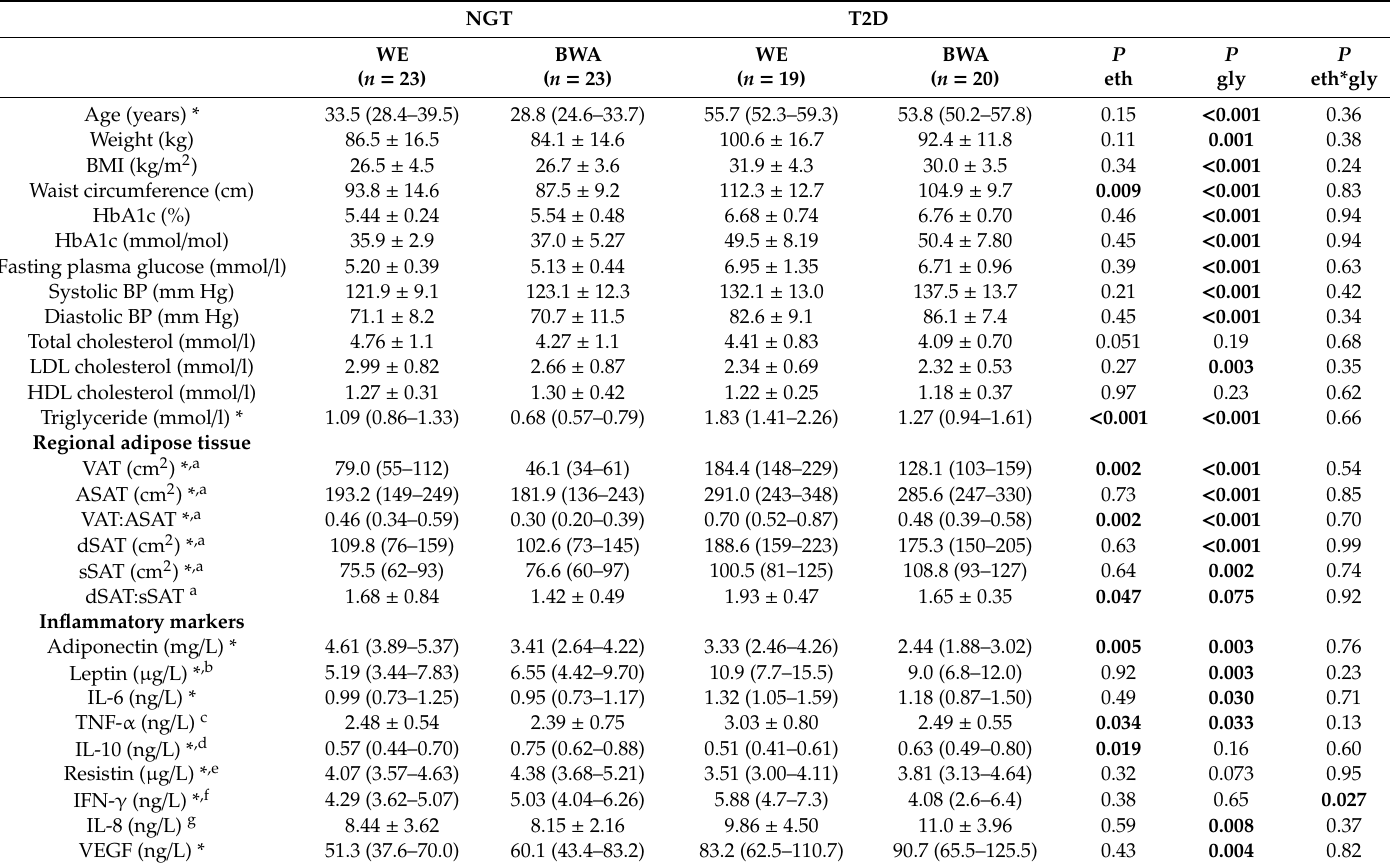
Table 1. Clinical characteristics, regional adipose tissue deposition and inflammatory markers in the white European (WE) and black West African (BWA) men with normal glucose tolerance (NGT) and type 2 diabetes